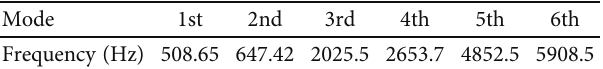
Figure 10: Finite element model of test probe. Table 7: Probe frequency calculation results.